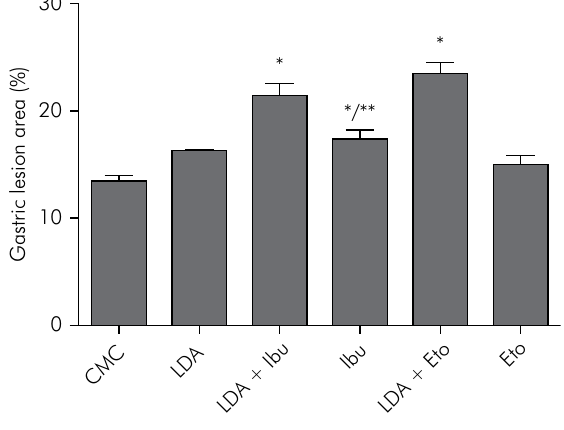
Figure 1. Gastric lesion percentage for each